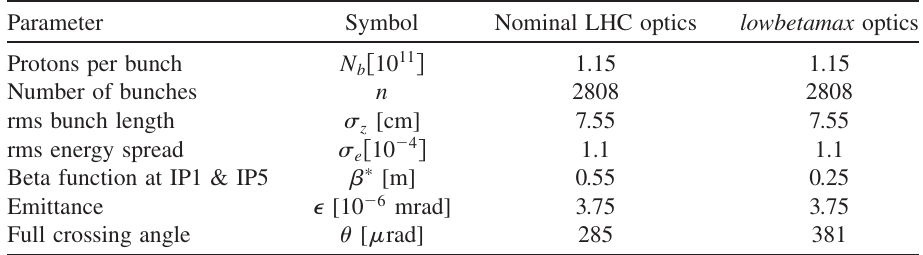
TABLE I. Relevant parameters of the two LHC optics under